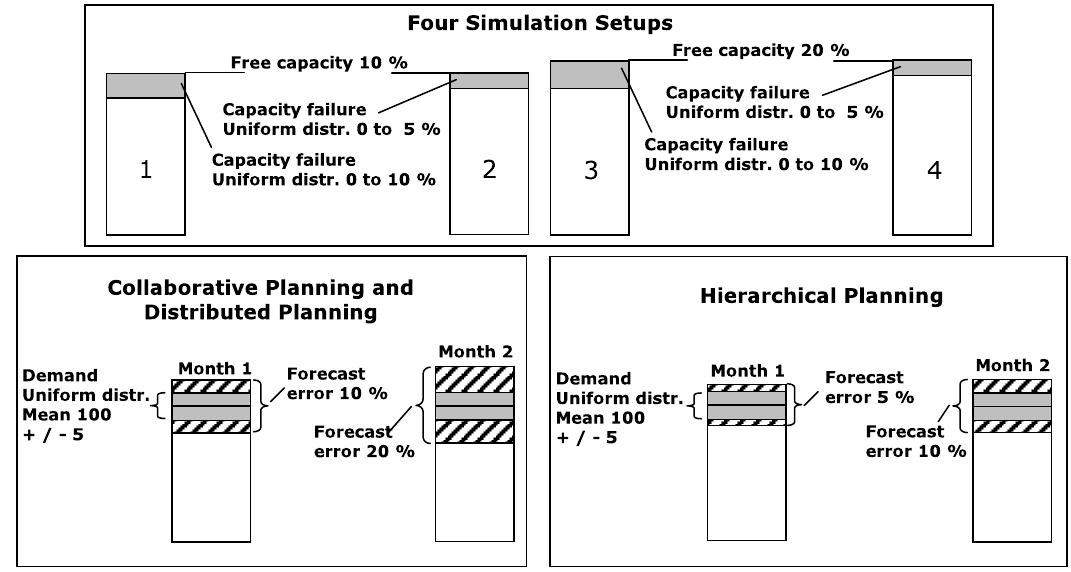
Figure 4. “General simulation set-ups for coordination forms (demand in 1.000 units)”.